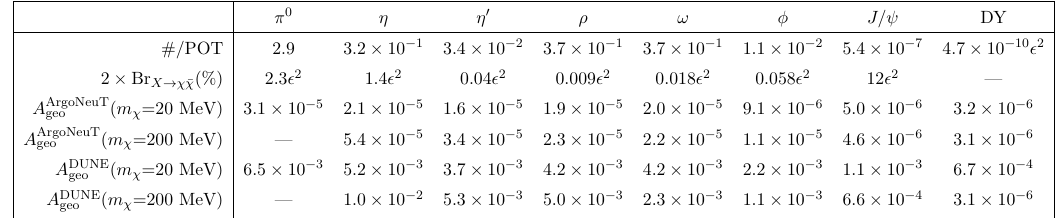
Table 1 . Meson production rates at a 120 GeV proton (cid:12)xed target facility and their branching fractions to pairs of light mCPs, and the number of mCP pairs from DY production. The phase space suppression factors for branching fraction calculations are further implemented in our calculation for heavier mCPs. The geometric acceptance A geo of ArgoNeuT and DUNE ND for each production mode are shown for two mCP mass